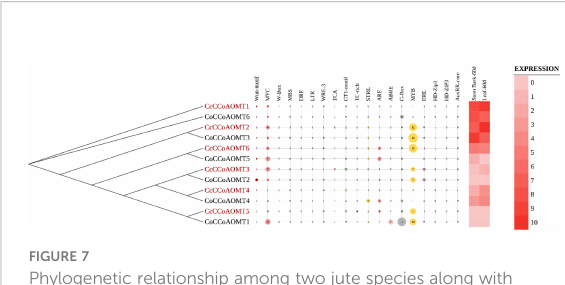
FIGURE 7 Phylogenetic relationship among two jute species along with their different stress-responsive cis-elements to demonstrate their regulatory response upon stress and in-silico expression pro fi les of different tissues (60 days old stem bark and